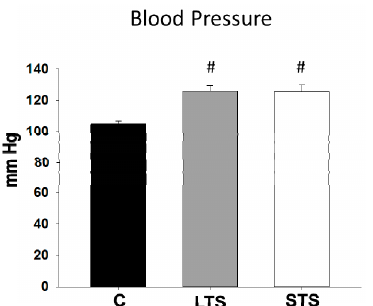
Figure 1. The effects of long-term (LTS) and short-term (STS) administration of sucrose on systolic blood pressure. C-control, MS-metabolic syndrome rats receiving sucrose for six months including the possible critical window, SP-rats receiving sucrose during the 16 days of the possible critical window for hypertension development around weaning and then receiving 5.5 months of tap water. Data represent mean ± SEM, # p < 0.01 after one-way ANOVA, n = 10 determinations from 10 different animals of each group.